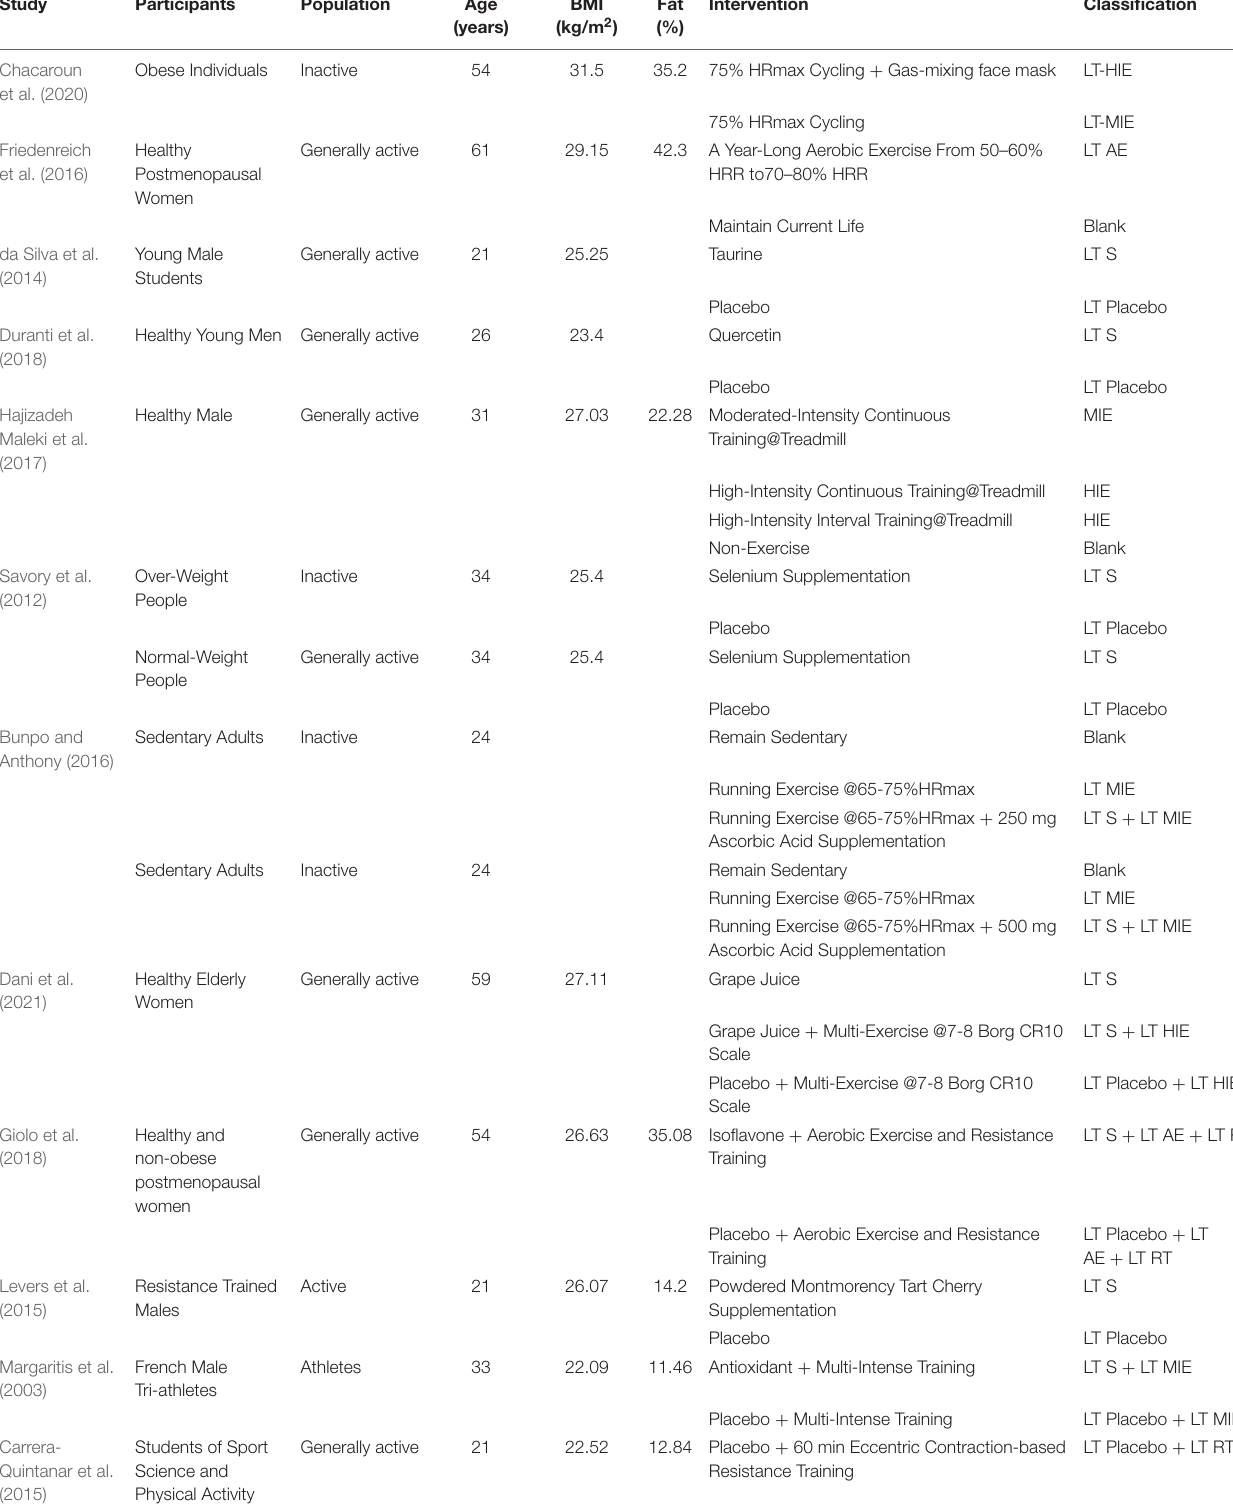
TABLE 2 | Information of the included studies explored the effect of different physical exercise and supplementation protocols on increasing plasma superoxide dismutase (SOD) under resting